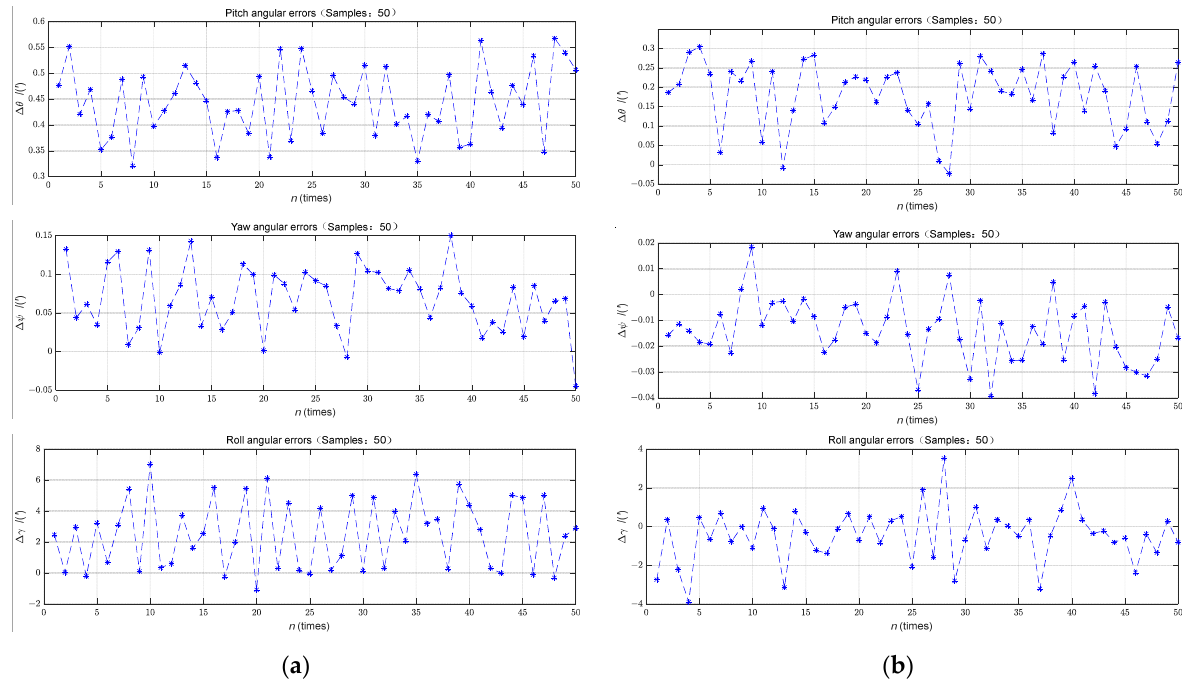
Figure 9. Alignment result statistics for 50 simulations: ( a ) Scheme A; ( b ) Scheme B.